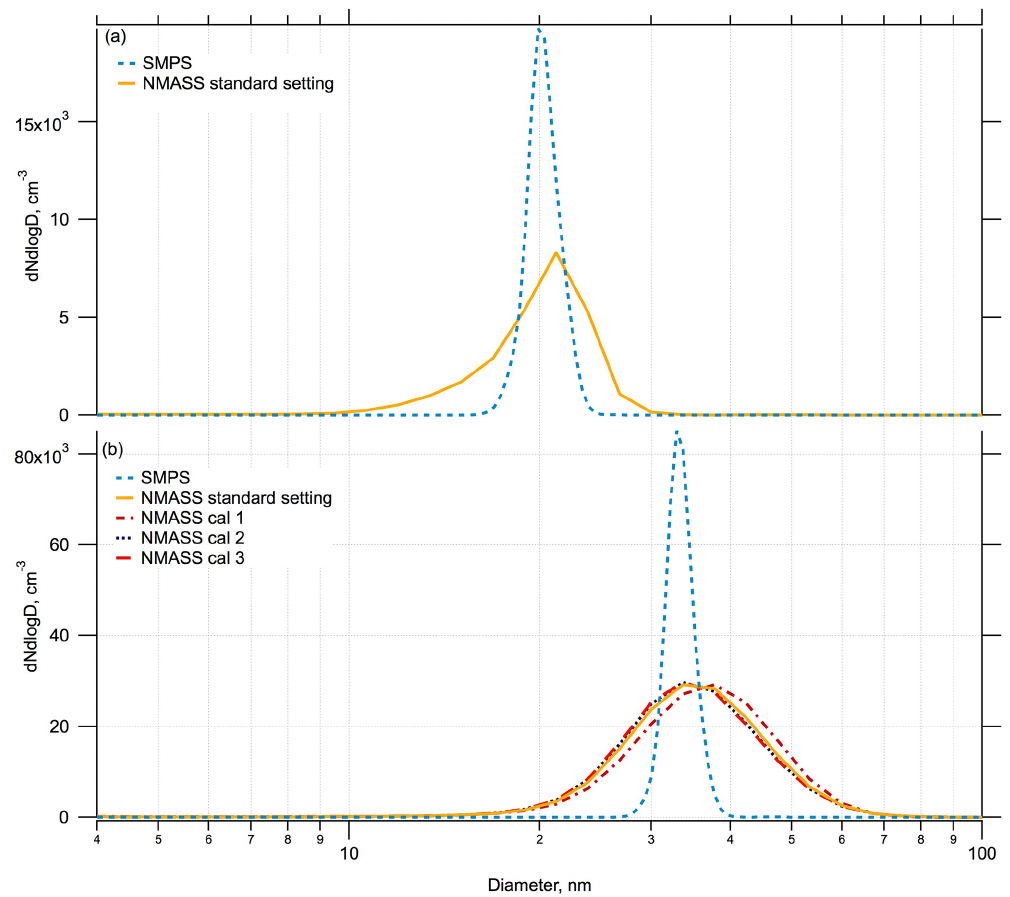
Figure 10. Comparison of SMPS and NMASS inversions for size distributions produced by atomized ammonium sulfate particles size selected by a DMA: panel (a) shows a narrow 20nm particle size distribution; panel (b) shows a narrow 32nm particle size distribution. Four different NMASS inversions are shown, using different known calibrations of NMASS 2 channel 5 (all other channel calibrations constant), to understand the effect of this instability (discussed in Sect. 3.5) on the 32nm